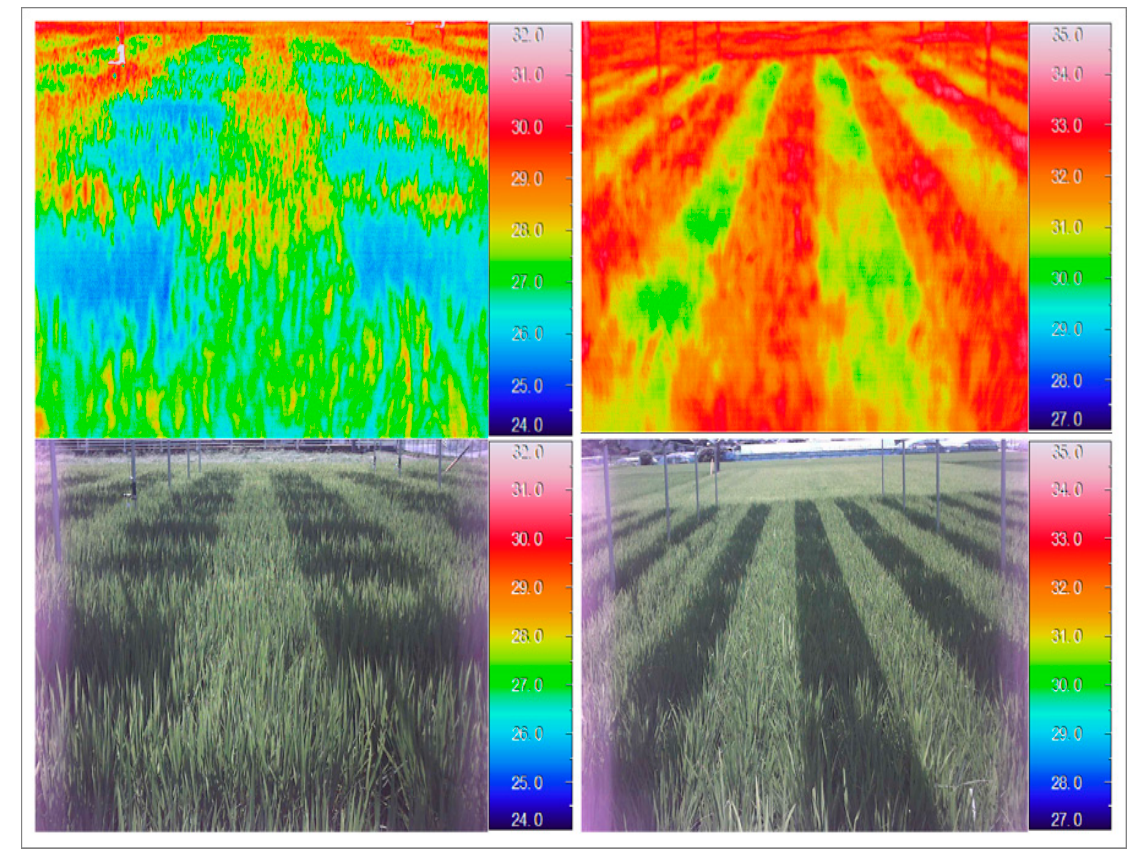
Figure 5. Surface temperature measurements using a thermo-camera on Farm B (left ) and Farm C ( right ).